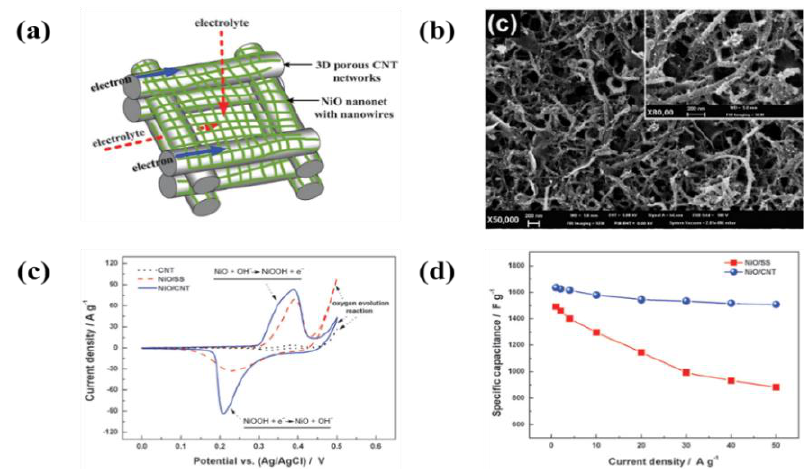
Figure 24. ( a ) Schematic diagram of a novel electrode structure of 3D porous CNT networks with an attached nickel oxide nanonet for supercapacitor applications; ( b ) SEM image of the CNT film with the attached NiO nanonet; ( c ) CV scans of the NiO without CNTs, NiO/CNTs, and bare CNTs electrodes at a scan rate of 10 mV · s − 1 ; ( d ) Relationship between the specific capacitance and discharge current density of the NiO without CNTs and NiO/CNT electrodes.